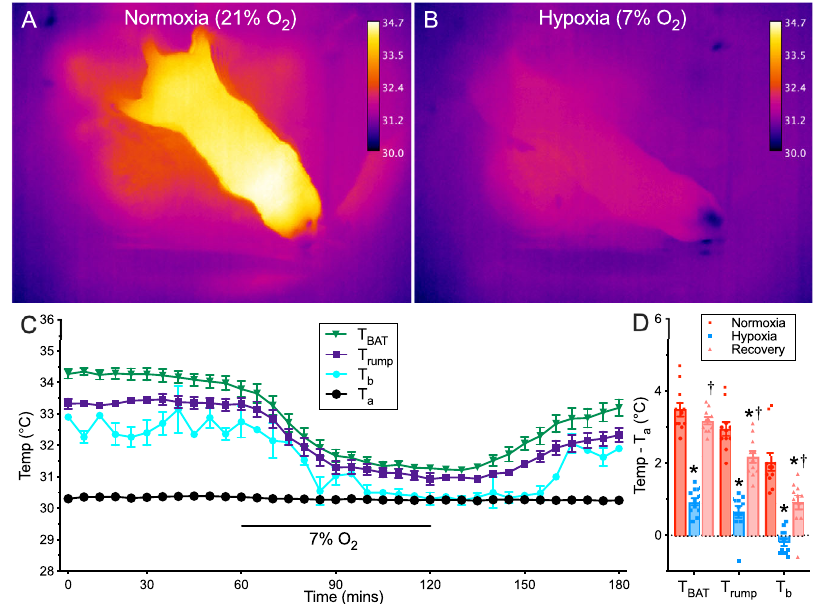
Fig. 1 Thermogenesis ceases in acute hypoxia and body temperature drops to ambient levels. A , B FLIR thermal images of a naked mole-rat following 60 min of exposure to normoxia ( A , 21% O 2 ) or hypoxia ( B , 7% O 2 ). C Summaries of ambient temperature ( T a , black circles), core body temperature ( T b , teal circles), interscapular brown adipose tissue temperature ( T BAT , green triangles), and dorsal skin surface temperature ( T rump , blue squares) from naked mole-rats exposed to a normoxia → hypoxia → recovery protocol in 30 °C ( n = 11 independent animals). D Summaries of temperature difference between physiological temperatures and T a in the fi nal 10 min of each treatment period from ( C ). Data are mean ± SEM. Asterisks indicate signi fi cant difference from normoxic controls; daggers indicate signi fi cant difference from hypoxia (repeated measures ANOVA with Tukey post-test; F 2,30 = 136.0, p < 0.0001). Source data are provided as a Source Data fi le.